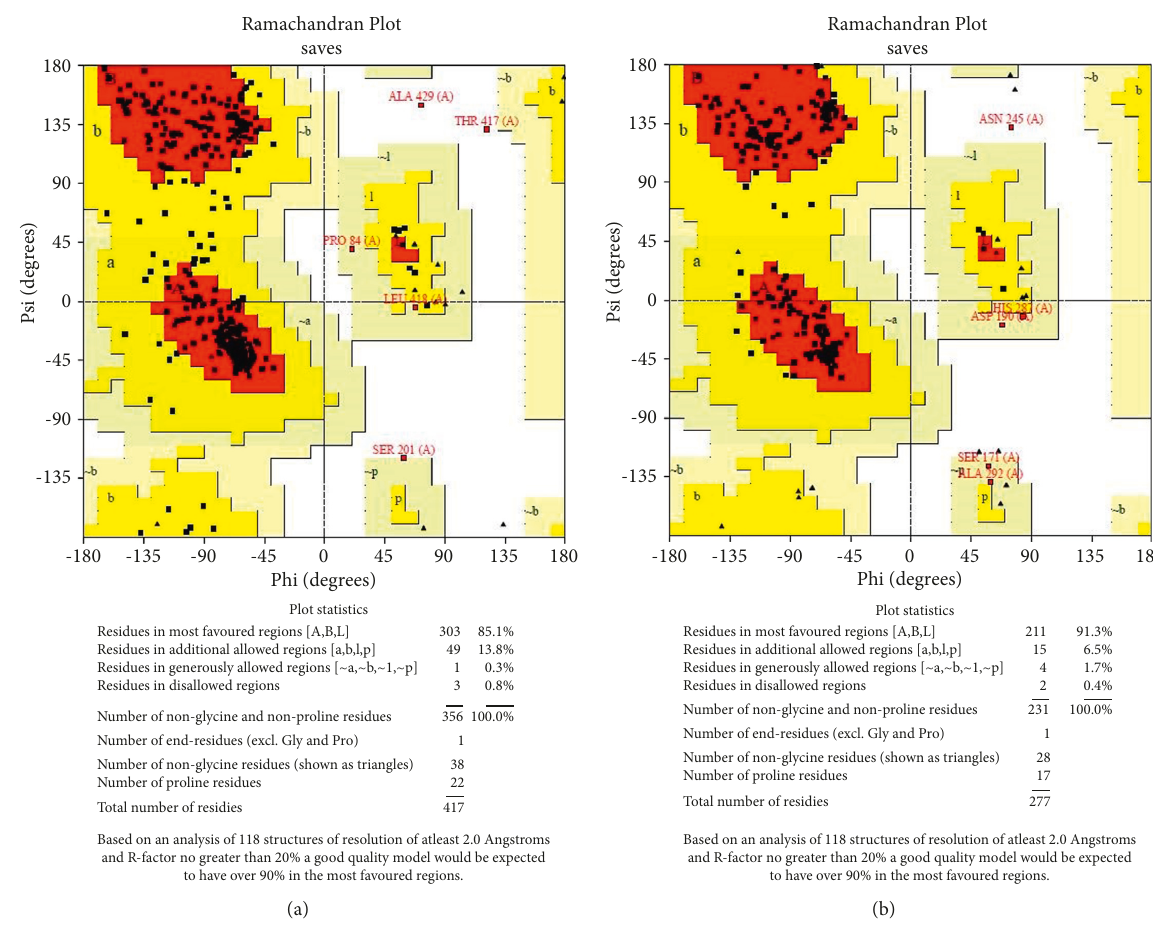
Figure 4: Ramachandran plot for lipase protein of (a) Malassezia furfur and (b) Malassezia restricta